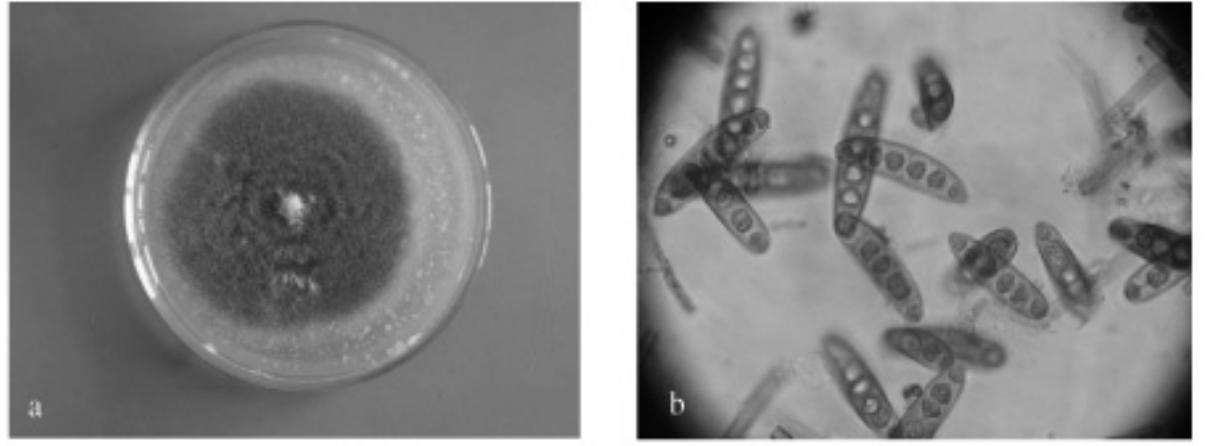
Fig. 1. Bipolaris cynodontis , (a) macroscopic aspect on rice fl our medium; (b)